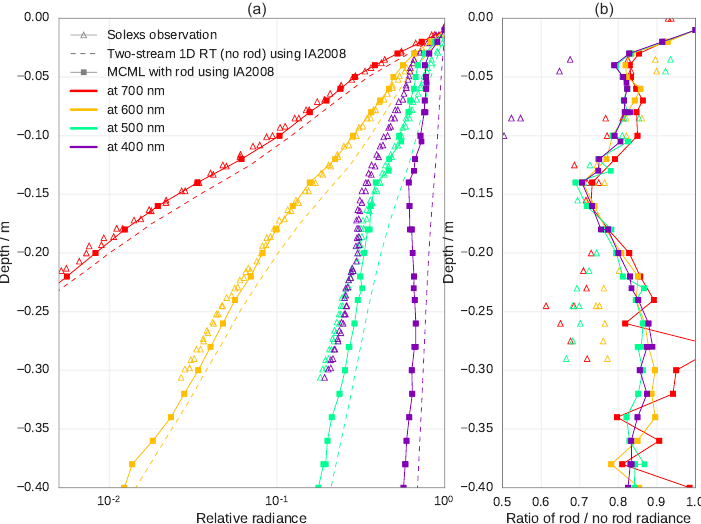
Figure 14. Log-radiance profiles at 400, 500, 600, and 700nm measured by SOLEXS at 25kmE_1 (25 km east of Concordia). Simulations with the 1-D model TARTES (without rod) and the 3-D model MCML using density and SSA profiles measured at the same point (Libois et al., 2014b). (b) Same as (a) but normalized by the ideal case computed with TARTES.